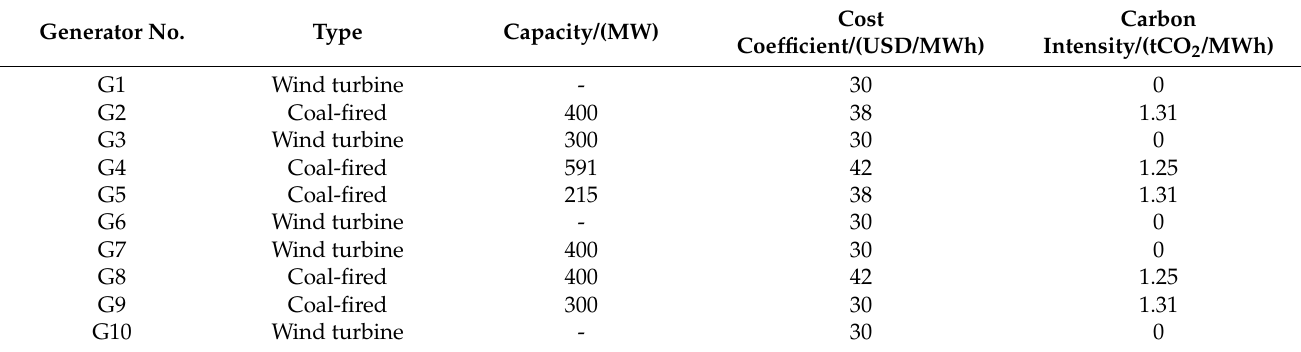
Figure 3. ( a ) Wind speed before and after the scenario reduction; ( b ) wind power output of reduced scenarios.